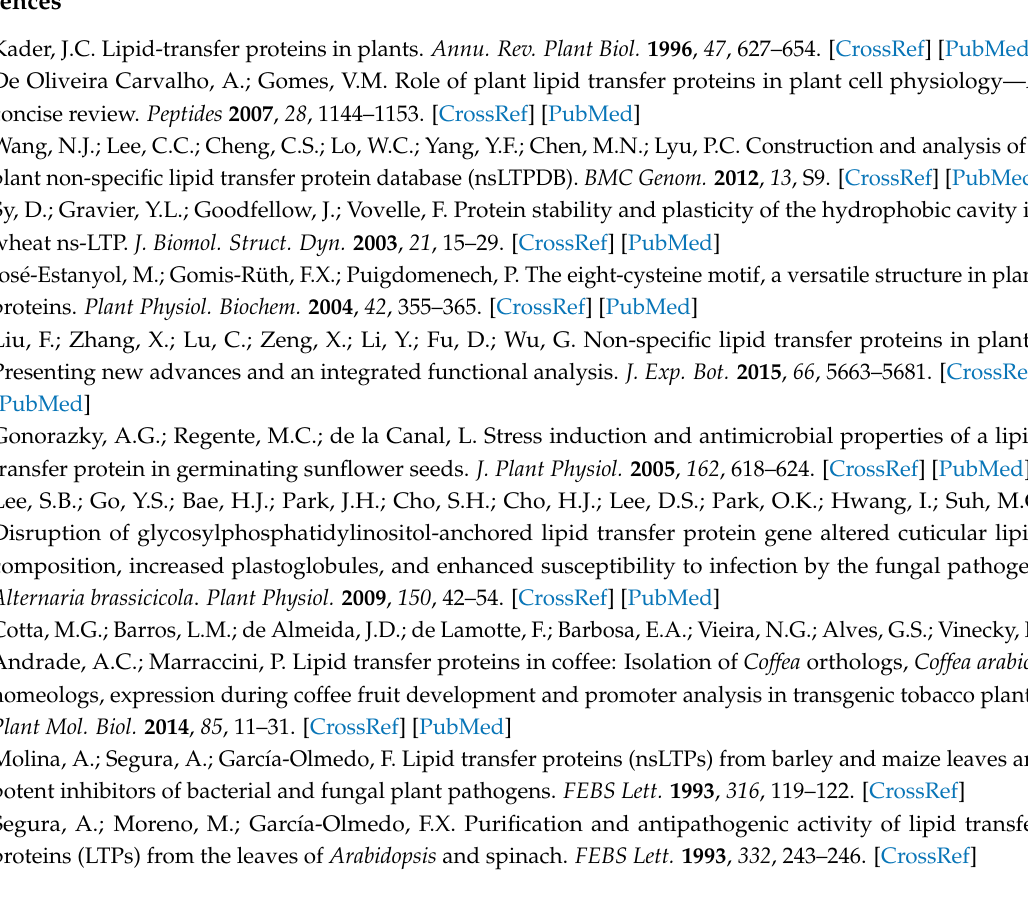
Figure S1: (A) Principal fungal structures observed in WT, MtN5hp and MtN5ox roots during the infection with R. irregularis . Figure S2. Validation of a set of DEGs by qRT-PCR analysis. Figure S3: Raw HPLC-APCI-MS chromatograms of roots of WT (black) and MtN5ox roots (red). Figure S4: Heat map (individual row-based) of signal intensity (in arbitrary units) of not annotated lipid ( m / z features) in WT plants and MtN5ox roots. Table S1: List of DEGs identified by microarray analysis in the comparison MtN5hp-inoculated roots versus WT-inoculated ones. Table S2: List of DEGs identified by microarray analysis in the comparison MtN5ox-inoculated roots versus WT-inoculated ones. Table S3: Identification n. (id), m / z (negative ionization mode), retention time (rt, in minutes), putative identification, lipid class, P(1) and P(2) loadings, peak area (in arbitrary units) in WT and MtN5ox samples. Table S4: Transcript ID, gene product and list of primers adopted for qRT-PCR analyses. Acknowledgments: This project was supported by a research grant provided by the University of Verona to